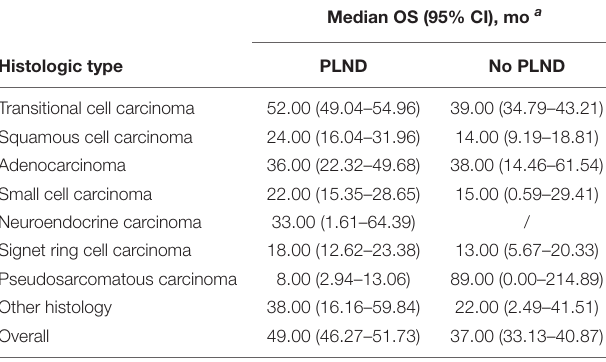
TABLE 3 | Median overall survival in patients with bladder carcinoma and variant histology within the SEER from 2004 to